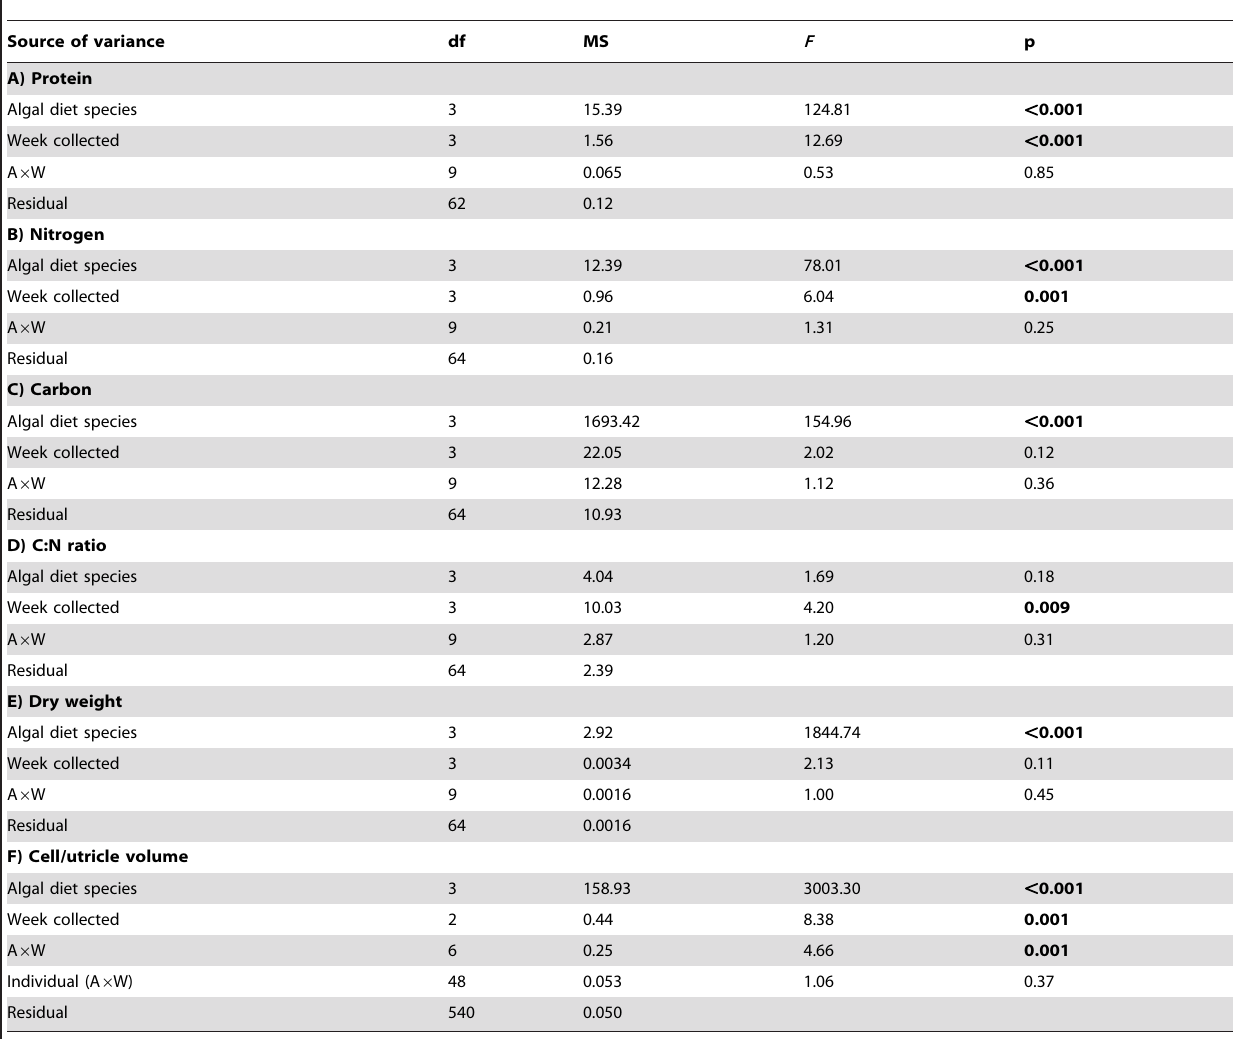
Table 1. Analysis of variance of A) protein content (% dry weight), B) nitrogen (N) content (% dry weight), C) carbon (C) content (% dry weight), D) C:N ratio, E) dry weight (% of wet weight), and F) cell/utricle volume (nl) of different algal diet species (A) in different weeks (W) during the growth experiment with Elysia viridis .